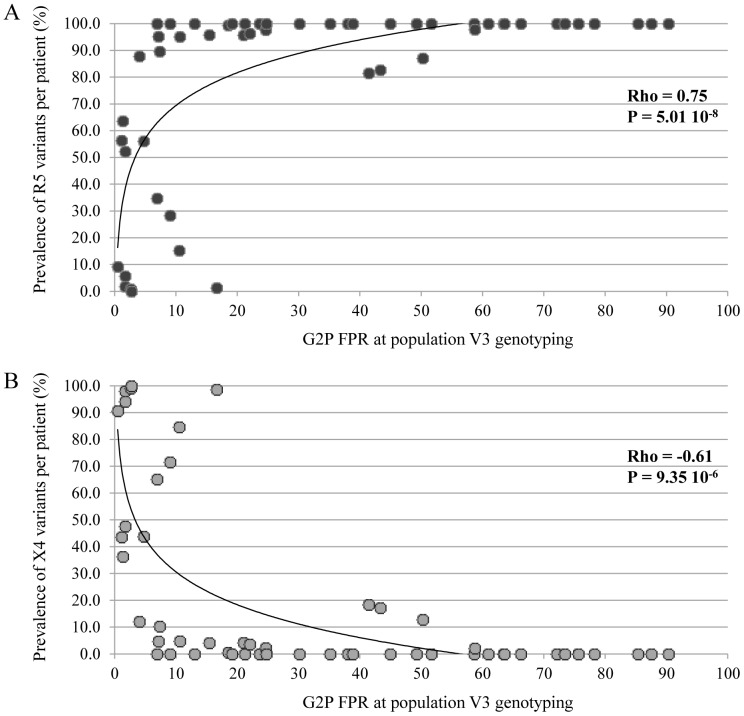
Distribution of R5 and X4 variants in relationship to the False Positive Rate (FPR) detected by population V3 sequencing. The graphs report the proportion of R5 (A) and X4 (B) variants per patient according to the values of FPR at population V3 sequencing. P-values were calculated by Spearman test. A FPR of 5.75 has been used as cut-off to infer HIV-1 co-receptor usage.